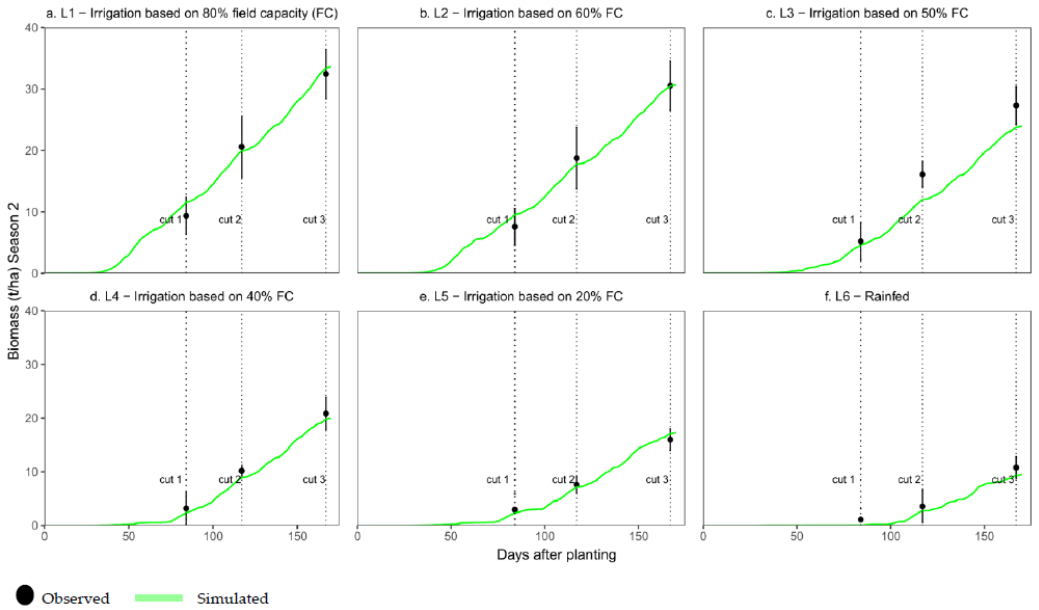
Figure 9. Observed and simulated cumulative biomass under different irrigation treatments during the second growing season (2021/22) of Guinea grass ( Megathyrsus maximus cv. Agrosavia sabanera). The error bars represent standard deviations. ( a ). Cumulative biomass for the treatment L1—irrigation based on 80% field capacity (FC); ( b ). Cumulative biomass for the treatment L2—irrigation based on 60% FC; ( c ) Cumulative biomass for the treatment L3—irrigation based on 50% FC; ( d ) Cumulative biomass for the treatment L4—irrigation based on 40% FC; ( e ) Cumulative biomass for the treatment L5—irrigation based on 20% FC; ( f ) Cumulative biomass for the treatment L6—rainfed.